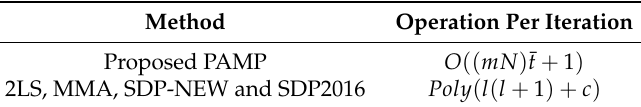
Table 6. Complexity